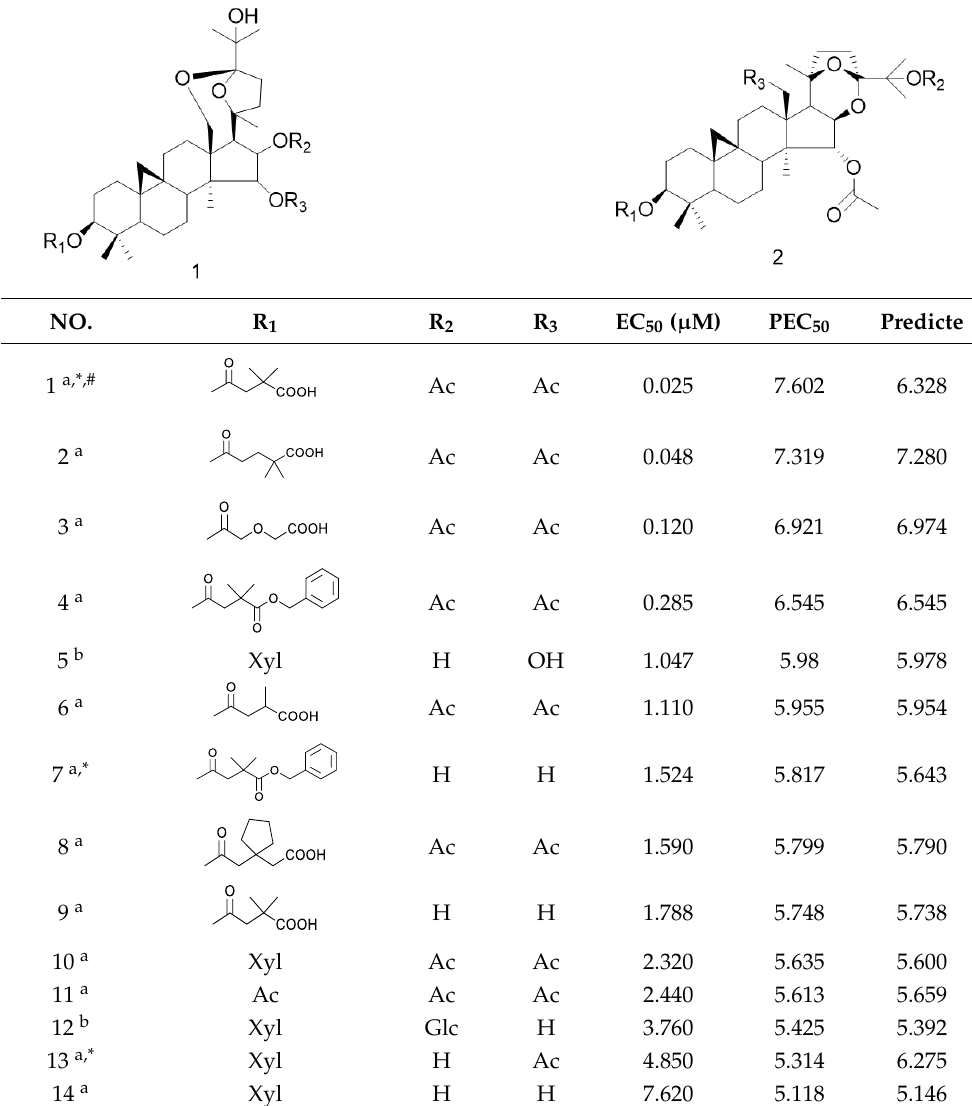
Table 2. Structures, EC 50 values of the actual and predicted by the best model.